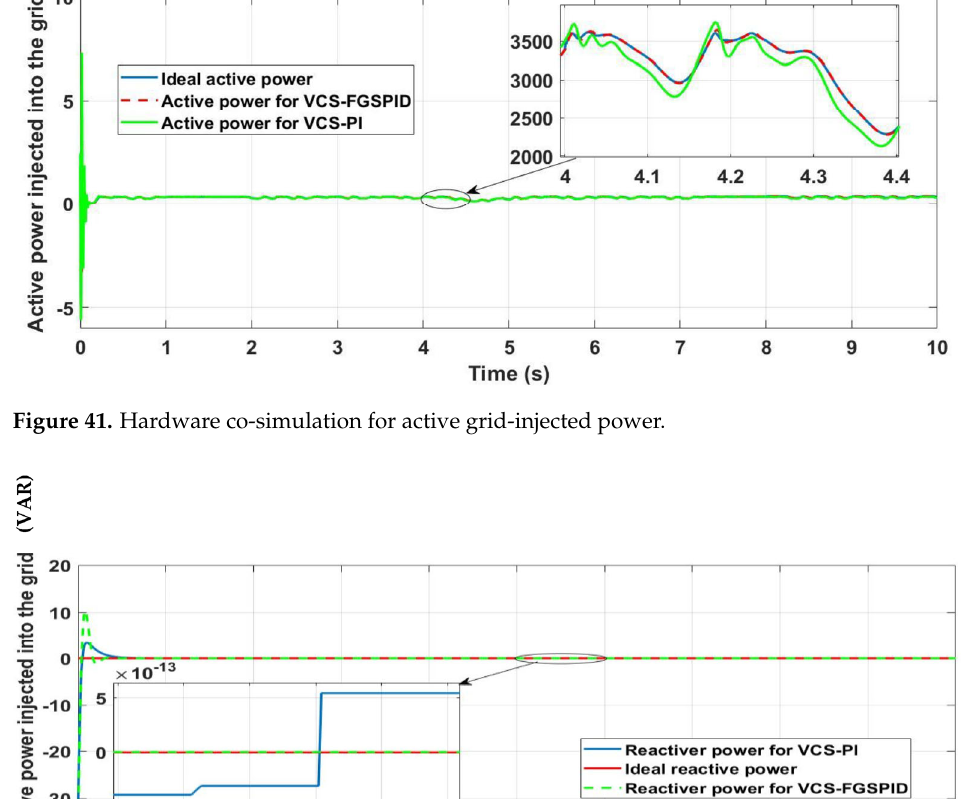
Figure 40. Hardware co-simulation for DC bus voltage.